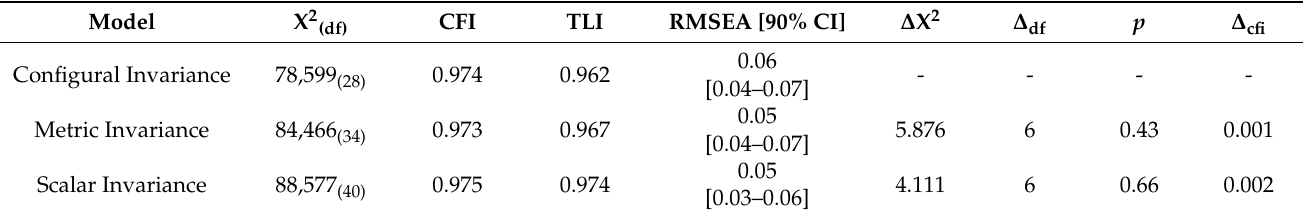
Table 2. Results of the CFAs testing the factorial invariance of the unidimensional model across age. Model